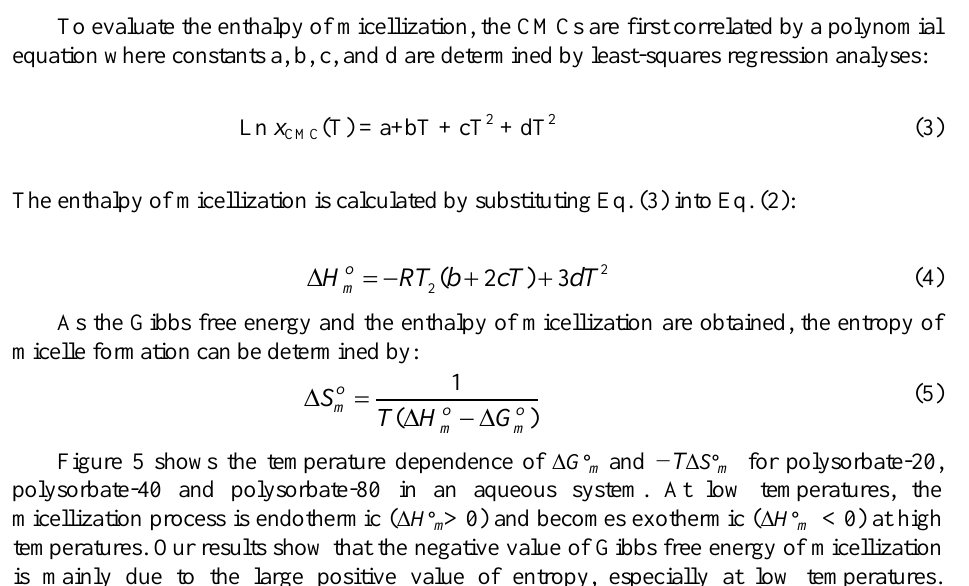
(squares) and − T Δ S ° (circles) as a function of temperature m m black, and grey